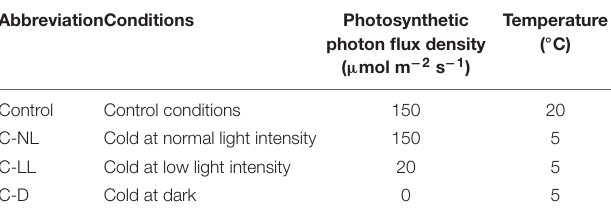
TABLE 1 | The specification of experimental conditions and the abbreviations of the respective experimental variants.